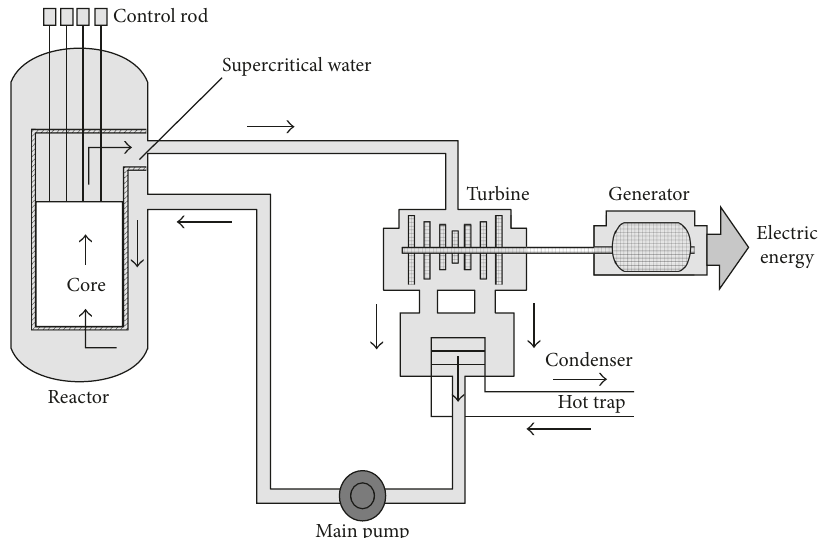
Figure 1: The schematic of the supercritical water coolant reactor.